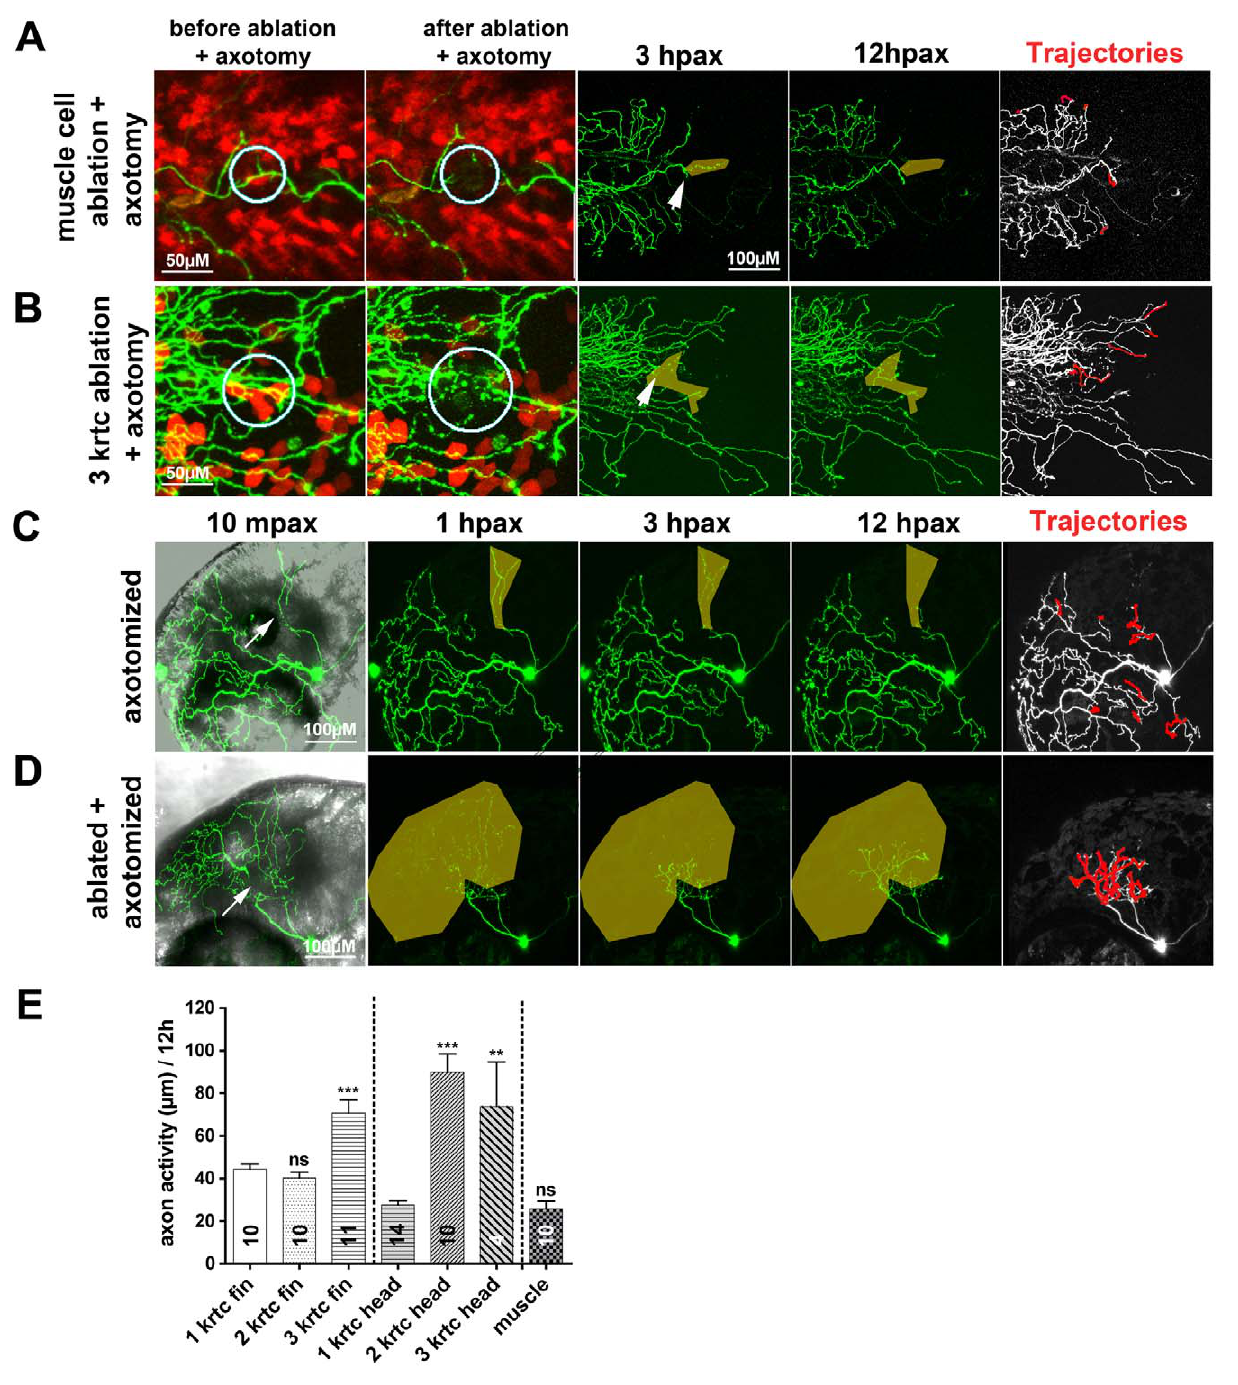
Figure 4. Keratinocyte damage promotes axon regeneration. Time-lapse sequences from 78–90 hpf. The rightmost panel shows axon tip trajectories (red) over the course of the time-lapse. (A) Ablating muscle cells (circles) in the fin of a transgenic reporter larva was accompanied by only limited regeneration of an axotomized arbor (arrow). (B) Ablating $ 3 keratinocytes (red) (circles) in the fin promoted axon regeneration after axotomy (arrow) and improved reinnervation of denervated territory (shaded area). (C) Axotomy of a trigeminal axon branch in the head (arrow) induced limited growth of the severed axon, but the denervated territory was avoided (shaded area). (D) Ablation of $ 3 keratinocytes and axotomy of a trigeminal axon (arrow) promoted robust growth of the severed axon and reinnervation of the denervated territory (shaded area). (E) Quantification of axon activity after keratinocyte and muscle cell ablations. Sample size for each group is indicated by the number in the bar. Error bars represent the standard error of the mean. For statistical analyses, we performed one-way ANOVA and Dunnett’s post-test to compare individual groups to control groups (ablation of 1 keratinocyte in the fin or the head) (asterisks above bars indicate significance compared to control) ( p = ns . 0.05, ** p , 0.01, *** p , 0.001). krtc, keratinocyte.